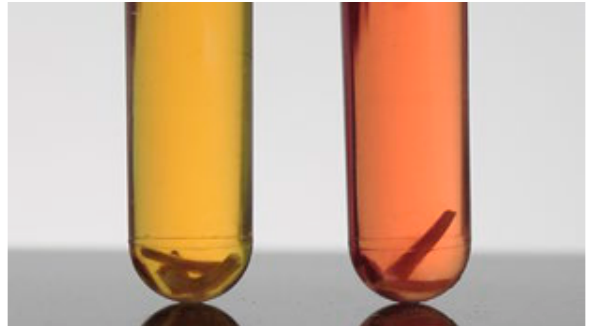
Figure 2. Acid colour change (lefthand tube), photo- graphed 15 days after inoculation with materials from a micropropagated shoot infected with phytoplasma strain CY-TO. Righthand tube inoculated at the same time with healthy micropropagated